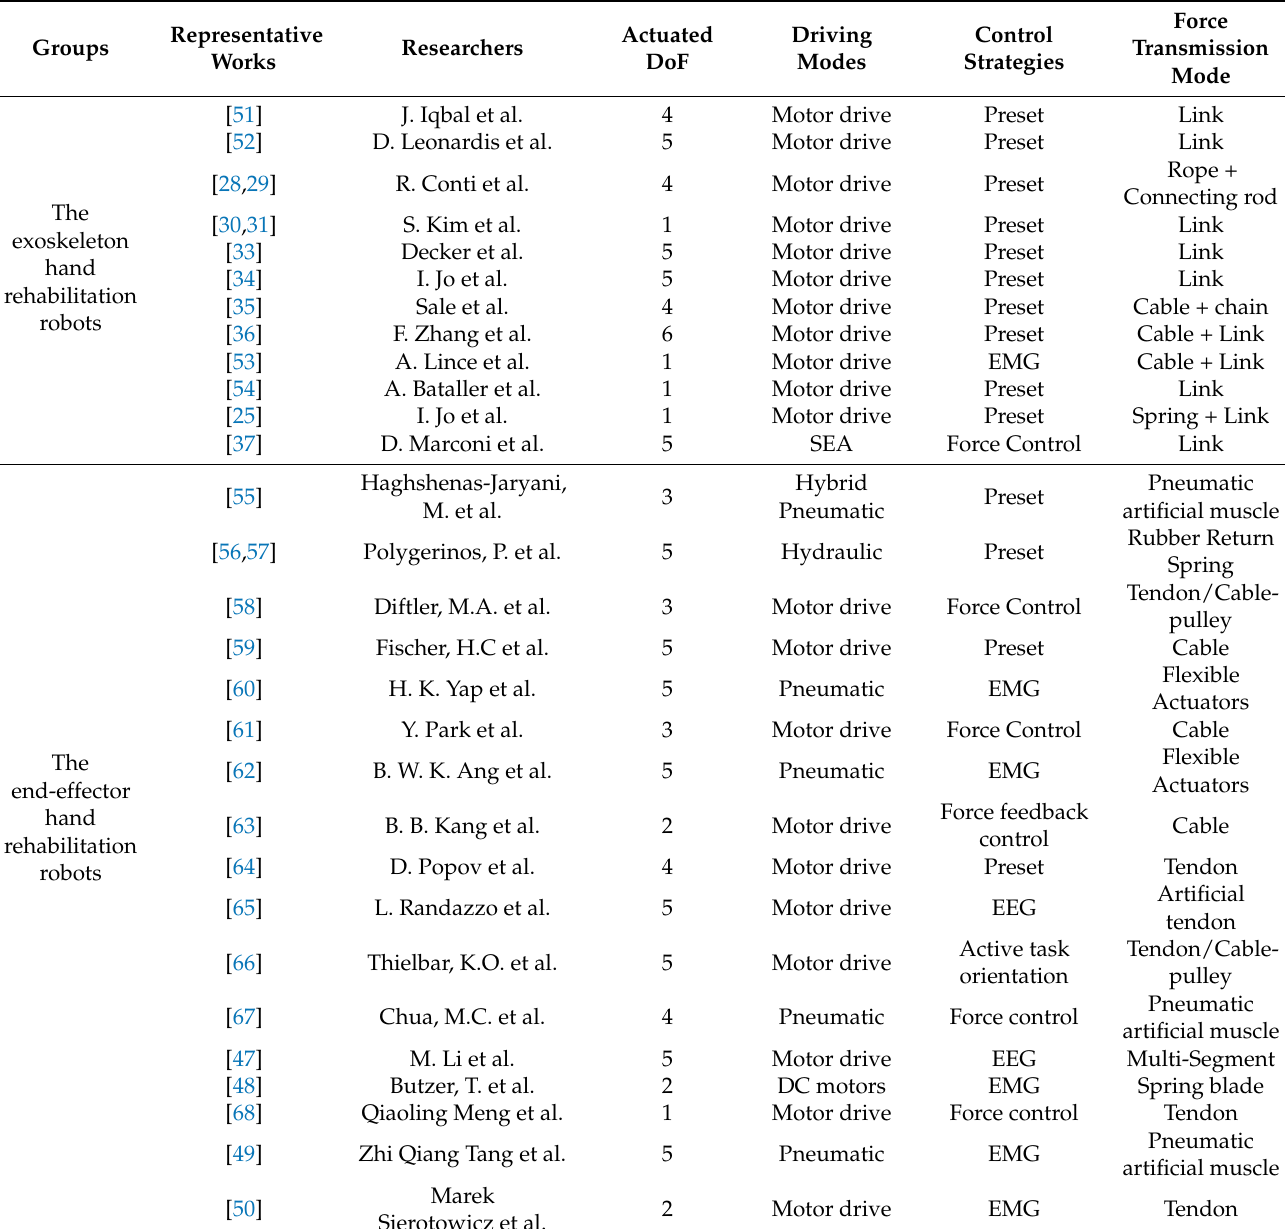
Figure 9. ( a ) Close-up view of the probabilistic model-based learning control of a soft pneumatic glove; ( b ) Close-up view of the EMG-Driven machine learning control of a soft glove [49,50]. Table 1. Compiling an overview of hand rehabilitation robotics in recent